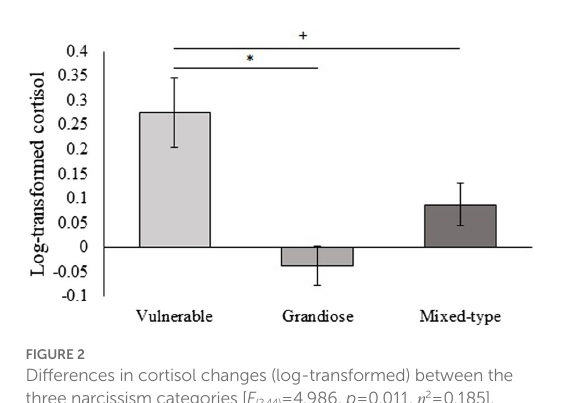
(2,44) = 4.986, p = 0.011, η 2 = 0.185]. Individuals high in vulnerable narcissism scores had greater cortisol response than individuals high in grandiose narcissism scores (*Bonferroni p = 0.015) and tend to have a greater response than individuals with mixed-type narcissism (+Bonferroni p =